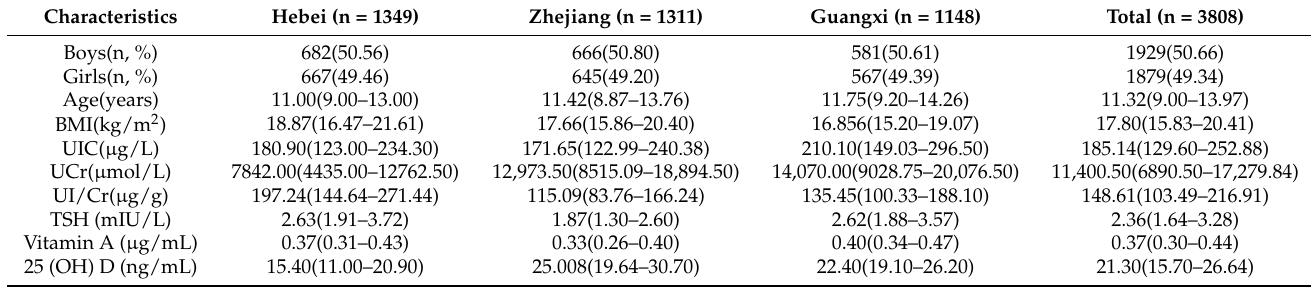
Table 1. Characteristics of Chinese school-age children from three different regions (median, P 25 –P 75 ).